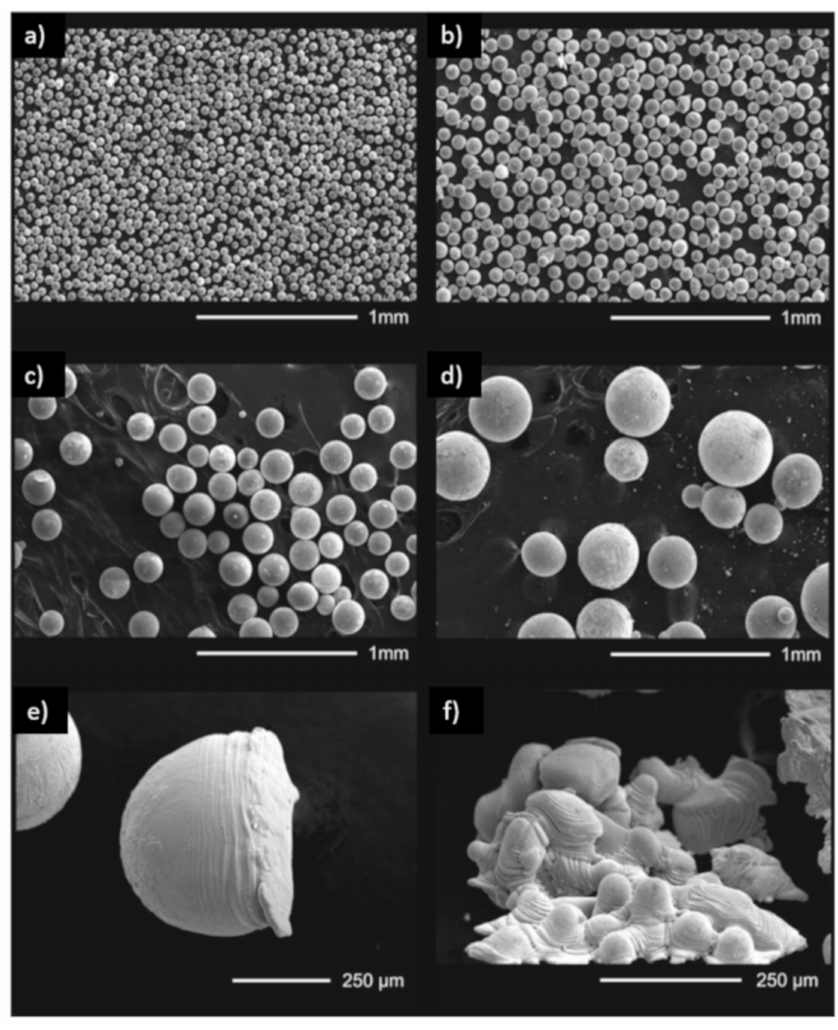
Figure 3. SEM images of ( a ) 0–50 µ m ( b ) 50–100 µ m ( c ) 100–200 µ m ( d ) 200–500 µ m of AISI 304 steel particles ( e ) the deformed powder particle and ( f ) the crystallized atomization site.